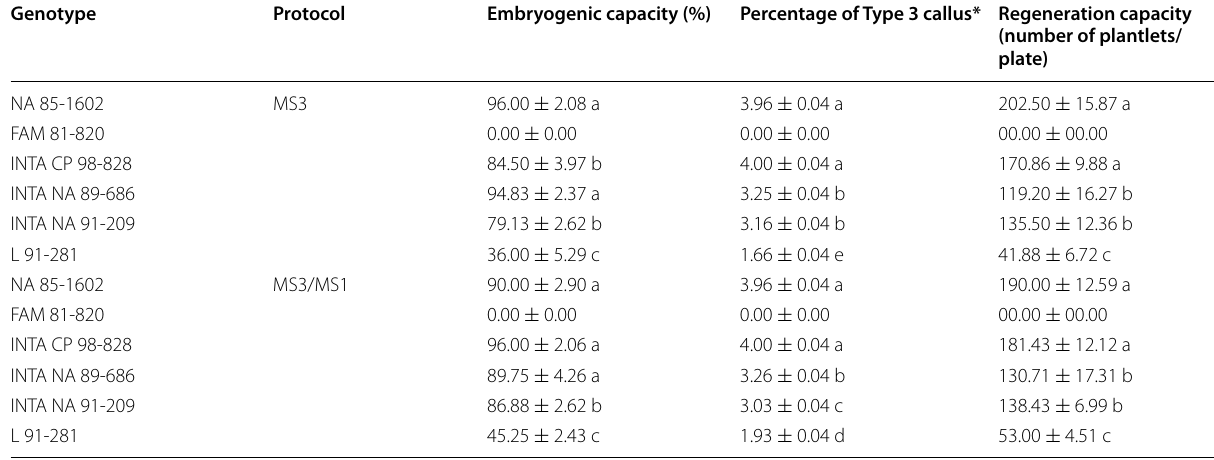
Means followed by the same letter do not differ according to the DGC test ( P < 0.05) *Visual scale 1 0–25%; 2 25–50%; 3 50–75%; 4 = = = =